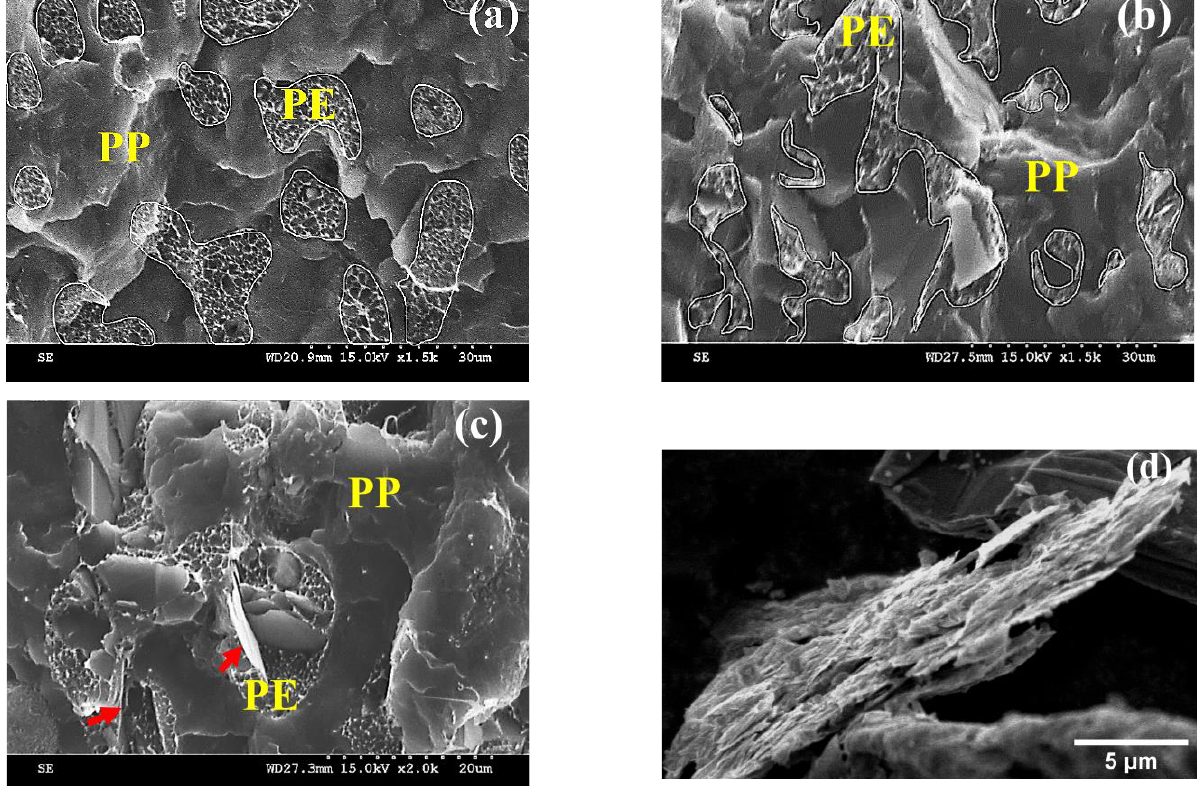
Figure 4. SEM images of ( a ) neat R-(PE/PP), ( b , c ) R-(PE/PP)/FLG = 96/4, and ( d ) FLG powder; in ( a , b) , the domain of the PE phase is marked by a white outline and in ( c ), the localization of FLG in the PE phase is marked by the red arrow to guide the readers’ eyes.